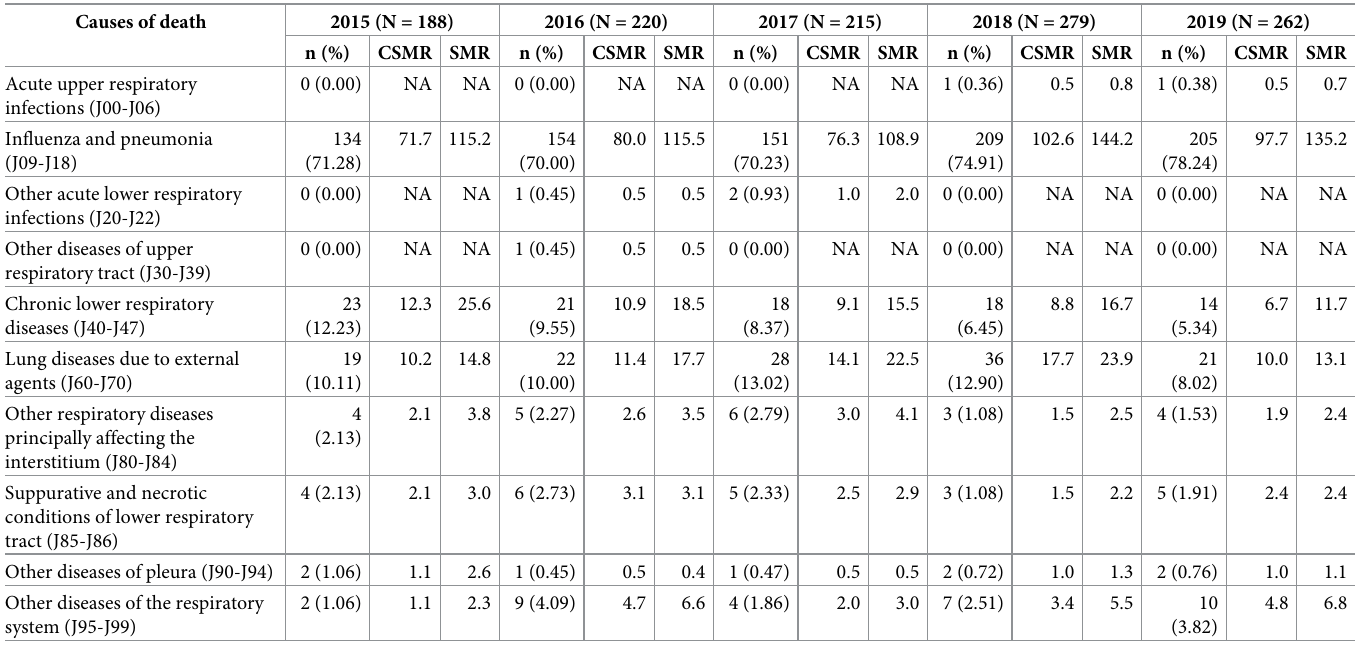
Table 7. Causes of death of people with intellectual disabilities by ICD-10-based diseases of the respiratory system from 2015 to 2019. Causes of